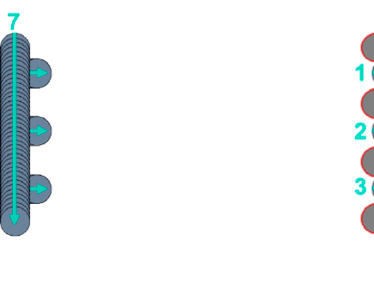
Figure 4. ( a ) Texturing process to generate micrometric square pillars; ( b ) texturing process to generate micrometric square pillars followed by irradiation of their tops.